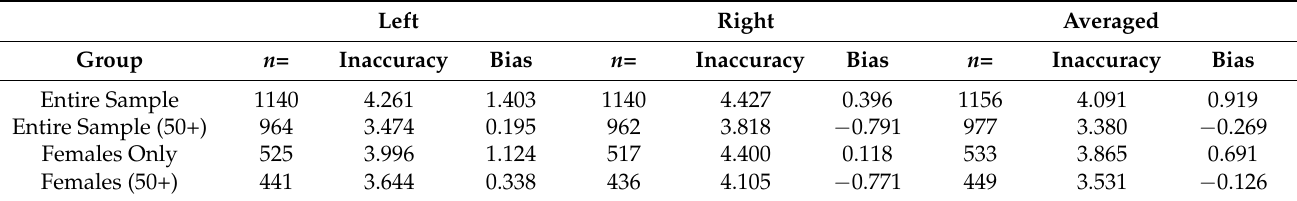
Table 3. Inaccuracy and bias (years): left face versus right face versus both faces averaged. Left Right